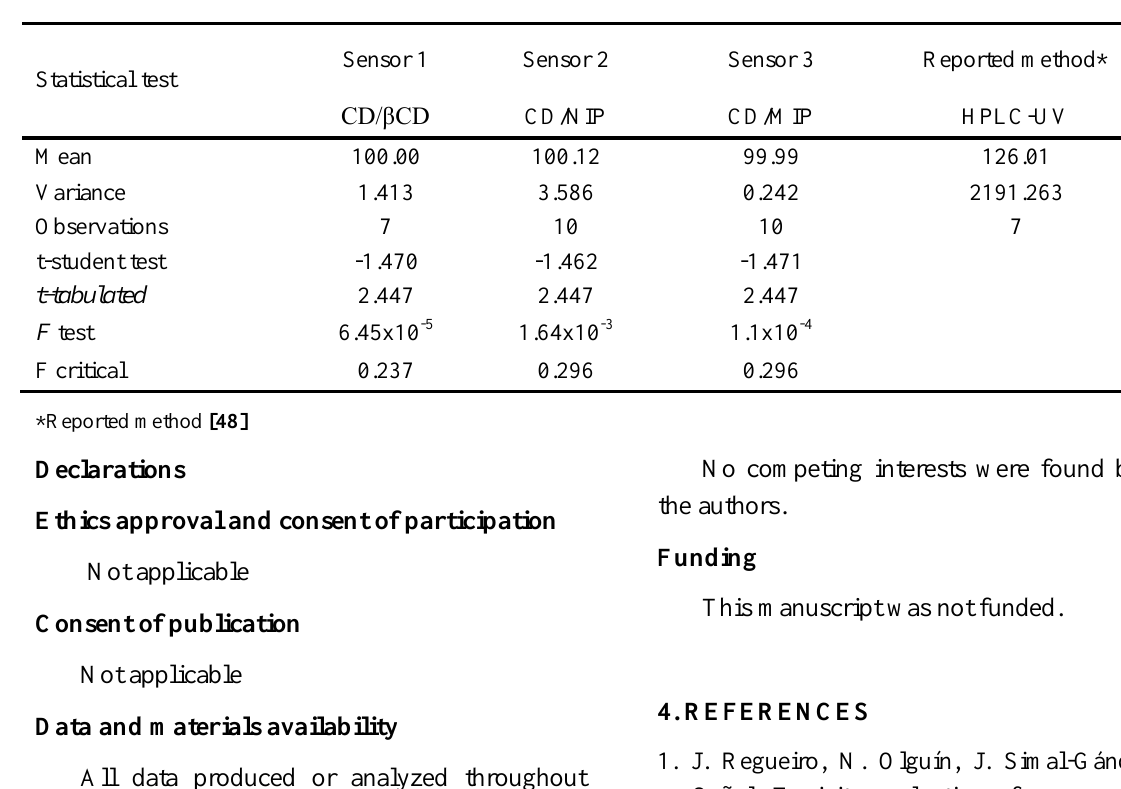
Table 4. Statistical t-student test and F-test of the results obtained from the seven suggested sensors with a reported HPLC-UV